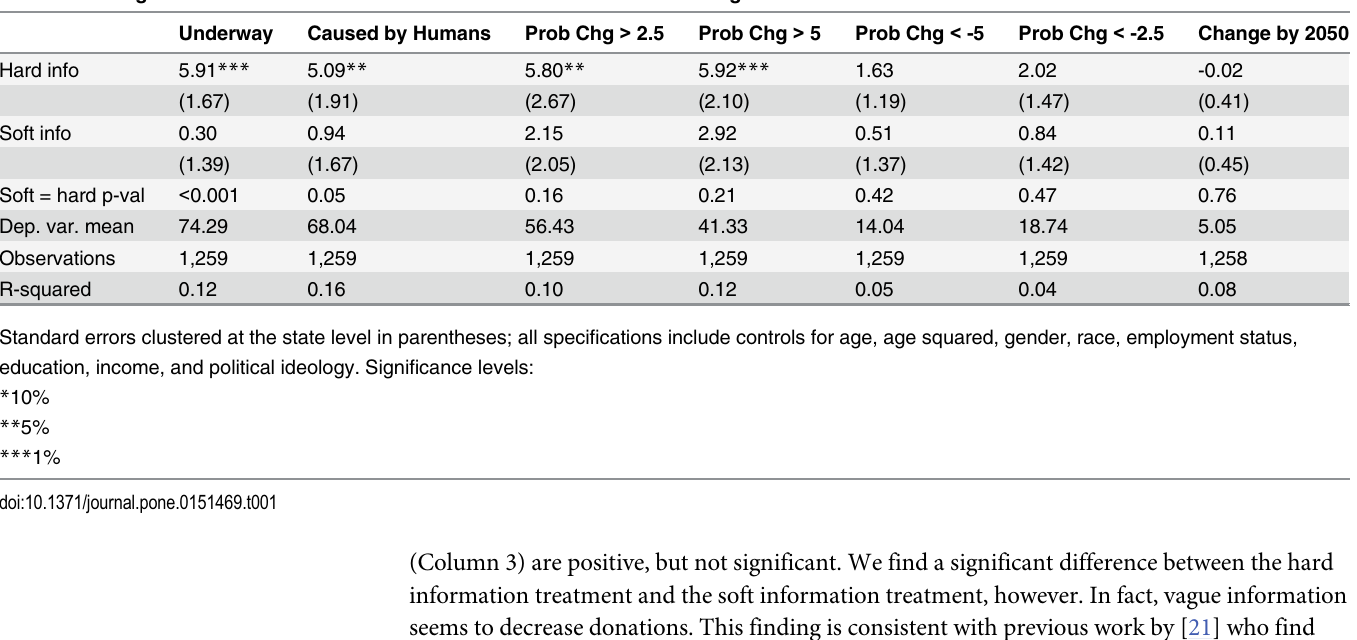
Table 1. Average short-run effects of information on beliefs about climate change.